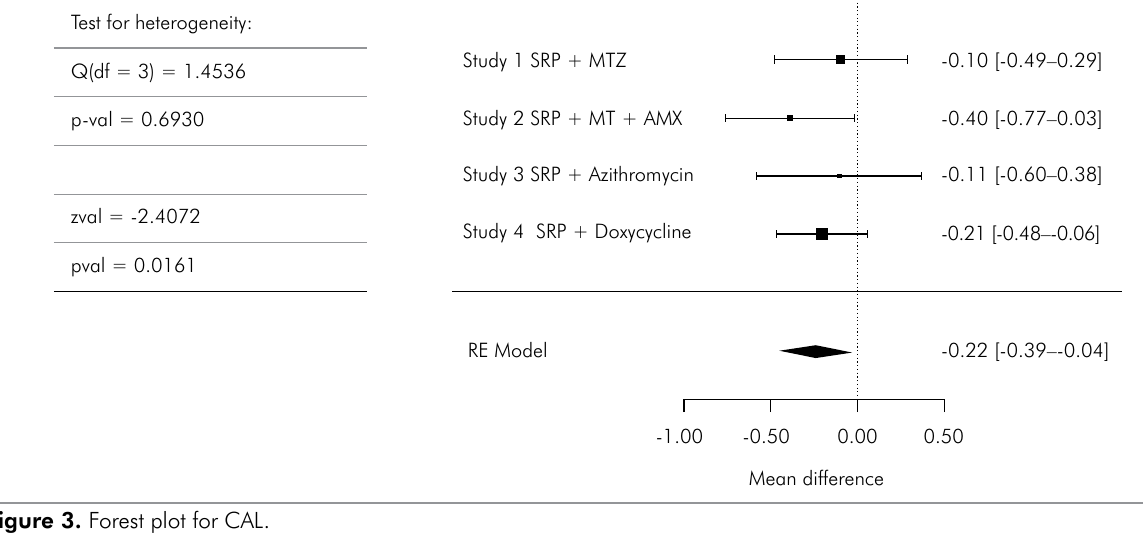
Figure 3. Forest plot for CAL.